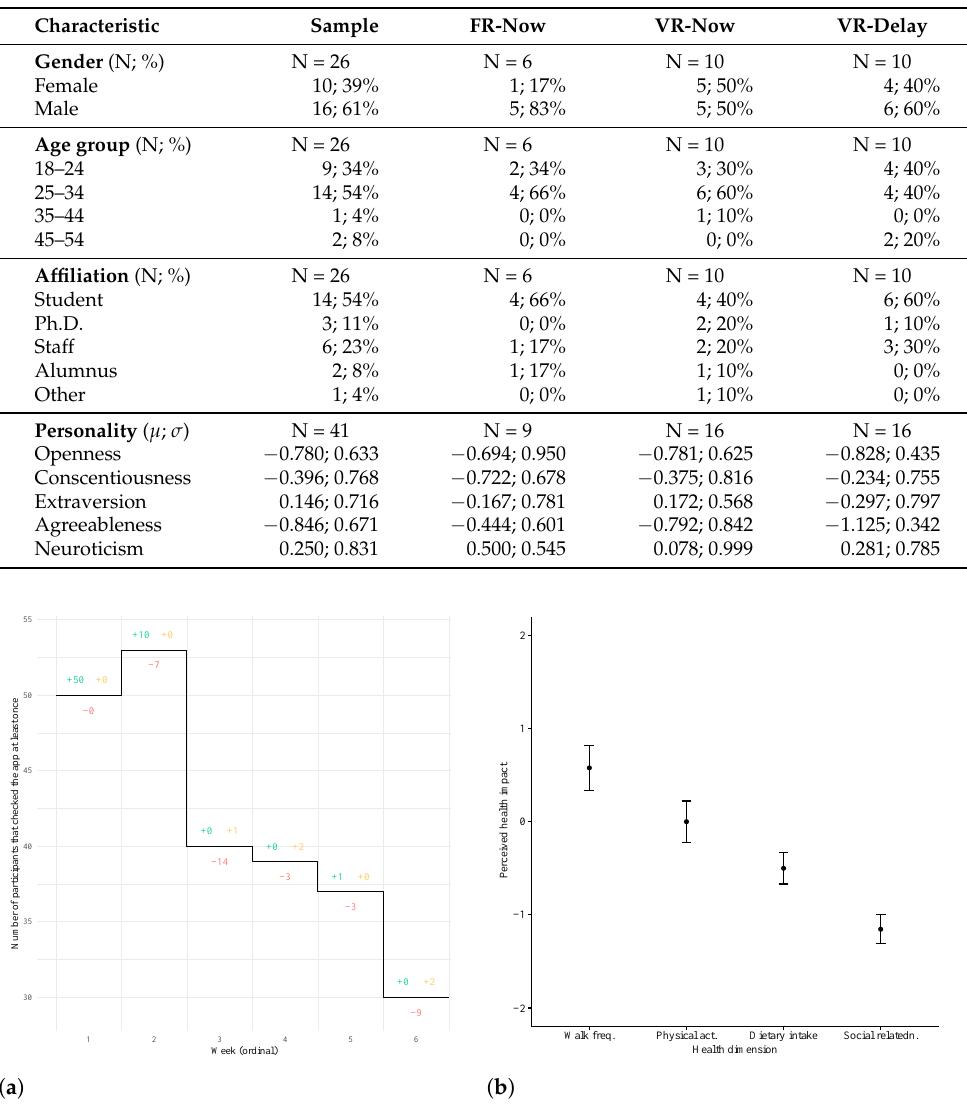
Table 1. Sample demographics based on pre-test and post-test survey responses.